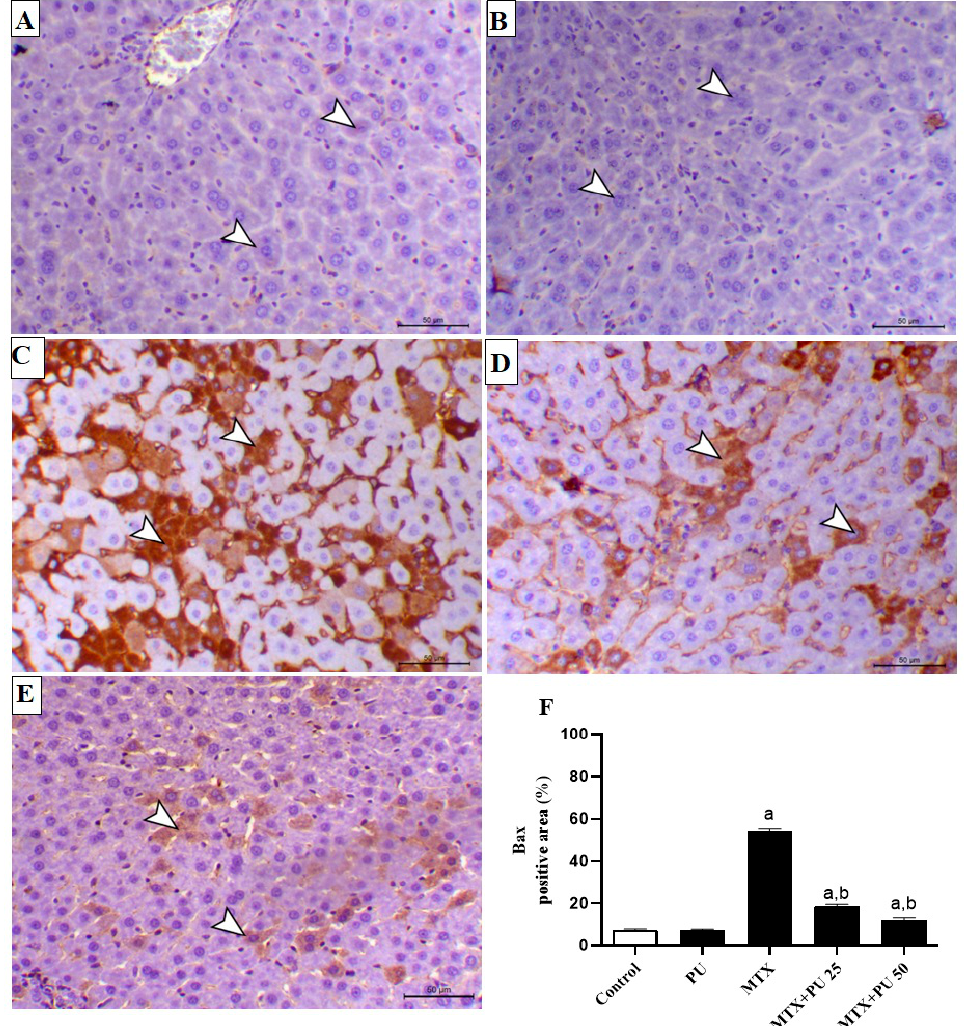
Figure 7. PU decreases hepatic Bax in MTX-administered mice. Image of hepatic microscopic field of ( A ) control and ( B ) PU-treated mice showing scanty hepatocytes’ expression of Bax (arrowheads); ( C ) MTX-injected mice showing marked immunoexpression of Bax within the hepatic tissues (arrowheads); ( D ) MTX-injected mice pre-treated with 25 mg PU demonstrating decreased Bax immunoexpression within the hepatic tissues (arrowheads); and ( E ) MTX-injected mice pre-treated with 50 mg PU demonstrating noticeable decline in hepatocytes’ Bax immunoexpression (arrowheads) (IHC, X200, Scale bar = 50 µm). ( F ) Image analysis of hepatic Bax immunostaining demonstrating significant elevation of Bax level in MTX-injected mice and significant decline of Bax level in MTX-exposed mice pretreated with both doses of PU. Results are expressed as mean ± SEM, ( n = 6). a indicates significant ( p < 0.05) vs. control, while b indicates significant ( p < 0.05) vs. MTX.